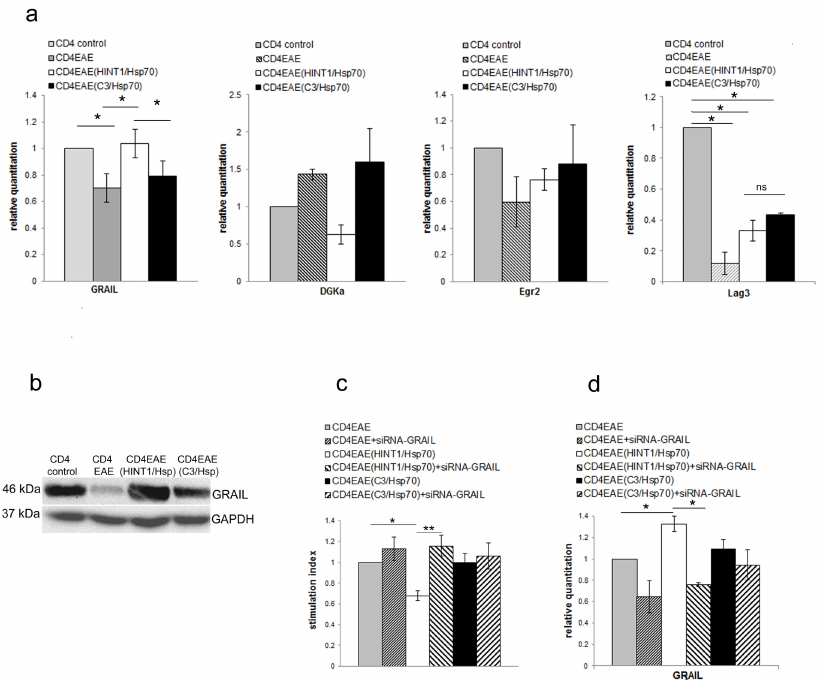
Figure 2. ( a ) Expression of mRNA for GRAIL, DGK α , Egr2 and Lag3 was measured with qRT-PCR in CD4 + T cells isolated from naïve SJL / J mice or EAE SJL / J mice non-pretreated or pretreated with HINT1 / Hsp70 or C3 / Hsp70. Ratio of mRNA was calculated versus the level of mRNA in CD4 + T cells isolated from naive mice. Data were pooled from three experiments with three to six mice per experiment. * p < 0.001; ( b ) GRAIL protein expression in CD4 + T cells isolated from EAE SJL / J mice non-pretreated or pretreated with HINT1 / Hsp70 or C3 / Hsp70 complex was analyzed by Western blot with usage of anti-GRAIL antibody. GAPDH was used as loading control. Blot is representative of three independent experiments; ( c ) The PLP 139–151 peptide induced proliferation of CD4 + T cells isolated from EAE SJL / J mice non-pretreated or pretreated with HINT1 / Hsp70 or C3 / Hsp70 complex was assessed by [3H] thymidine uptake. Stimulation indices are shown as mean ± SD obtained from four independent experiments with five to six mice per experiment. * p < 0.001, ** p < 0.05; ( d ) Inhibition of GRAIL expression in CD4 + T cells isolated from EAE mice non-pretreated or pretreated with HINT1 / Hsp70 or C3 / Hsp70 by siRNA-GRAIL transfection. Efficacy of GRAIL mRNA inhibition with siRNA-GRAIL transfection was assessed by qRT-PCR. Ratio of mRNA was calculated versus the level of mRNA in CD4 + T cells isolated from non-pretreated EAE mice. Data are pooled from four independent experiments with five to six mice per experiment. * p <